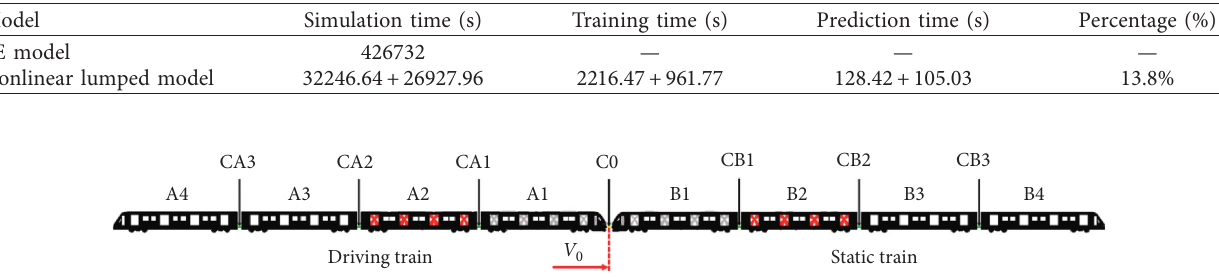
Figure 20: Head-on crash simulation between two 4-vehicle train sets.